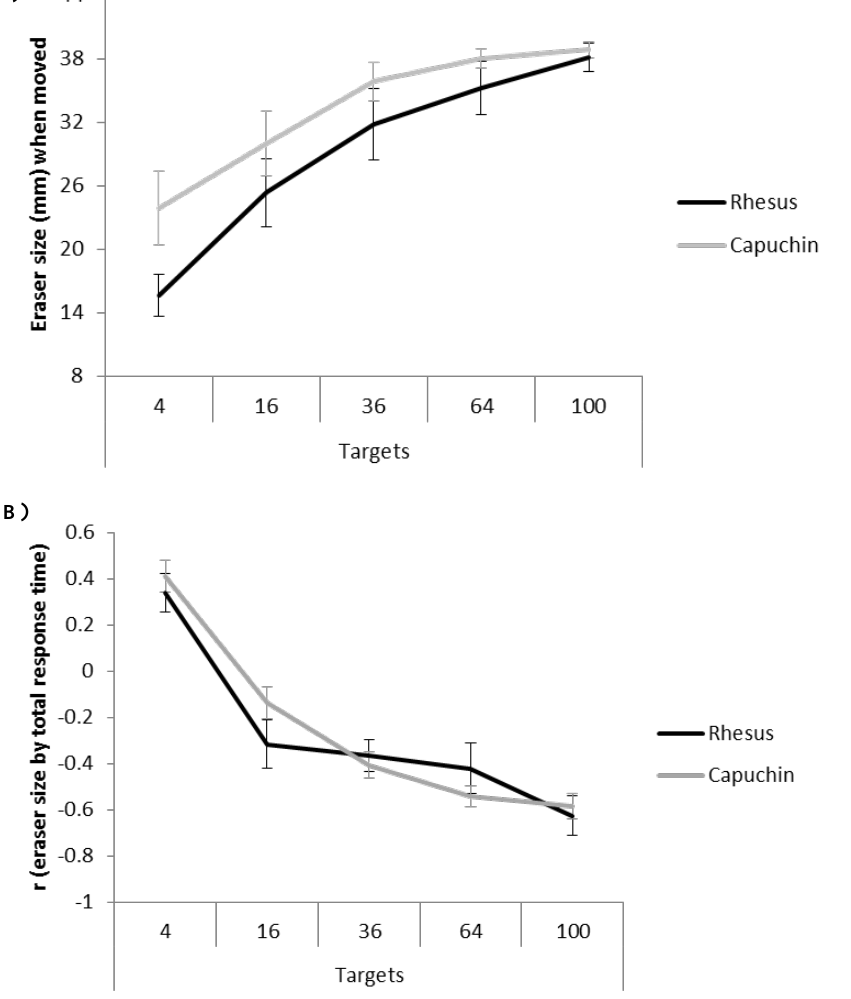
Figure 4 . Monkeys‟ performance in Testing Phase 2, as a function of target array size (x-axis) and species (separate lines). Panel (A) illustrates the mean size of the eraser before monkeys attempted to use it. Panel (B) shows the mean relationship (correlation coefficient) between final eraser size and total trial time. Note that all size values represent either the length or width of the stimulus (not the area). Error bars represent standard error of the